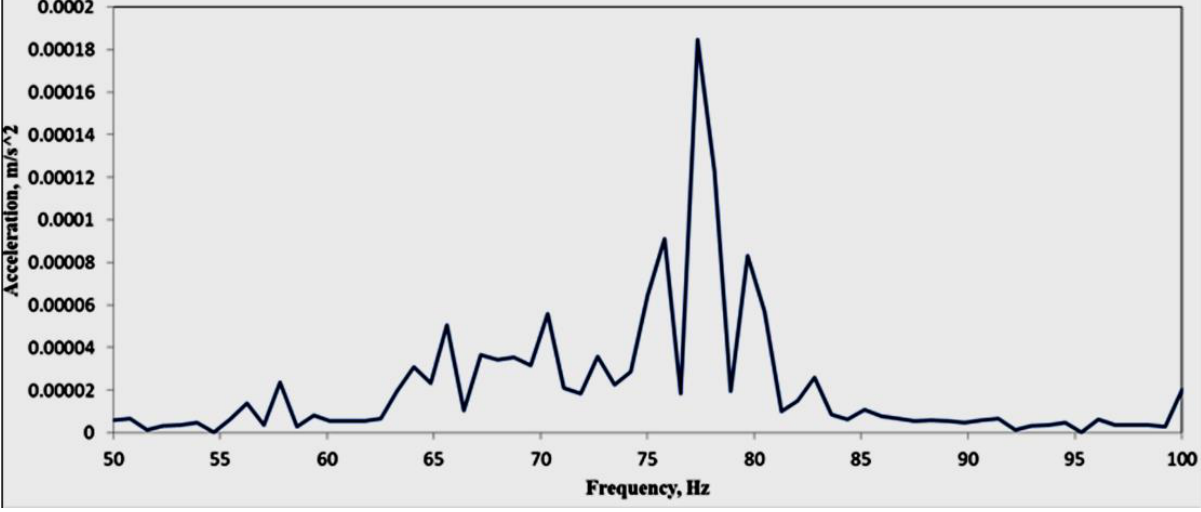
Figure 9. FRF of Healthy blade.